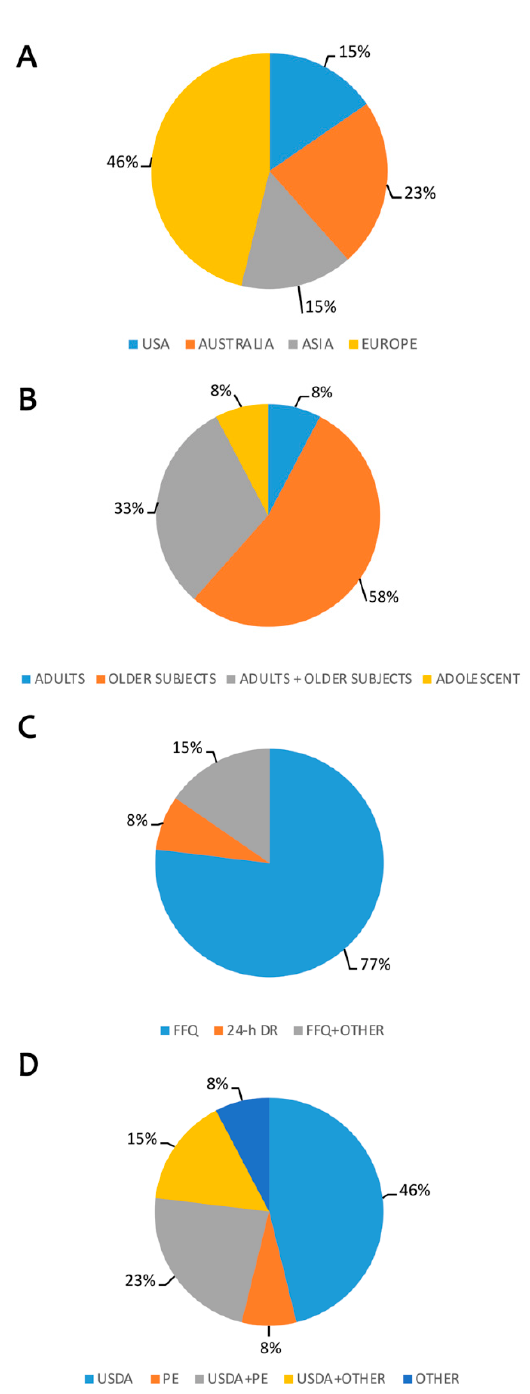
Figure 6. Estimation of polyphenols intake and other outcomes. Legend: ( A ) Distribution of published data by country; ( B ) Target population considered; ( C ) Questionnaires used to evaluate food intake; ( D ) Polyphenol database used for evaluation of intake. Legend: FFQ: Food Frequency Questionnaire; 24-h DR: 24-h Dietary Recall; USDA: United States Department of Agriculture; PE: Phenol-Explorer.